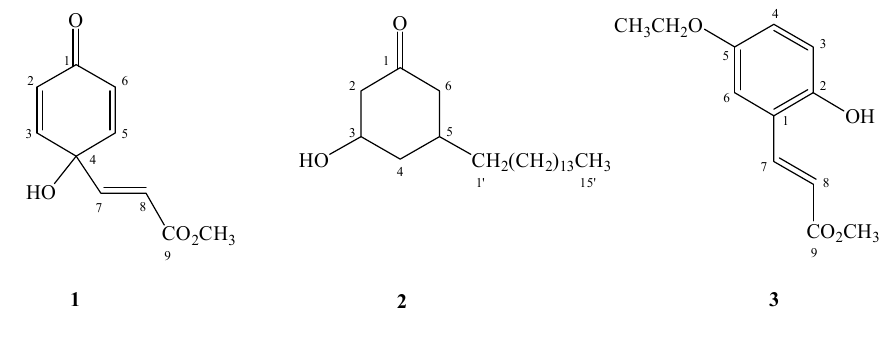
Figure 1. Structures of compounds 1–3